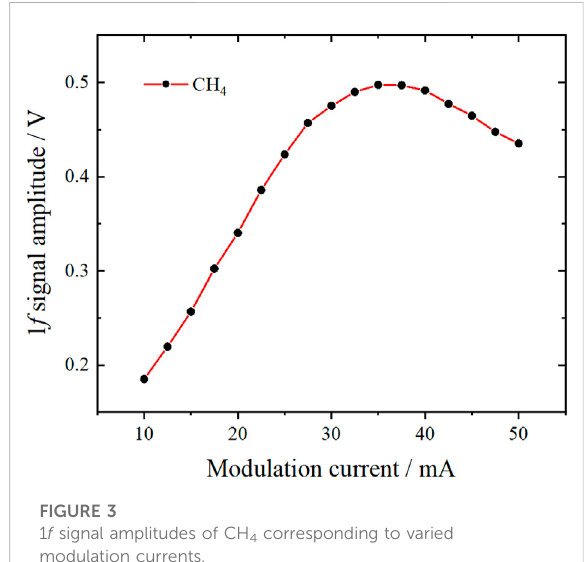
FIGURE 3 1 f signal amplitudes of CH 4 corresponding to varied modulation